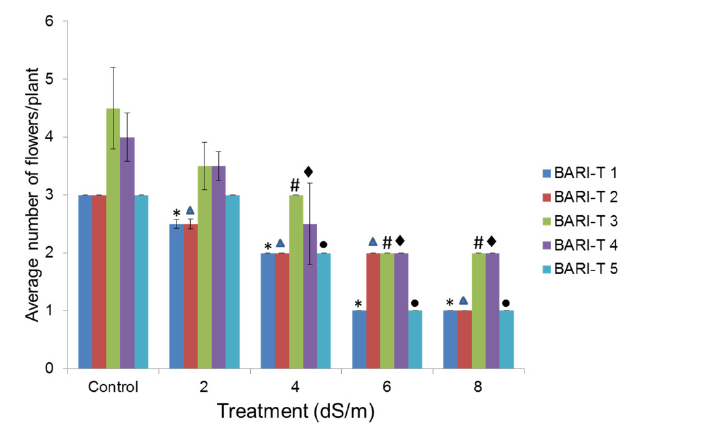
Fig. 5. Effects of NaCl-salinity on number of flowers in five BARI-T plants. Error bars indicate mean ± SD (n=3). Asterisk *, , #, ♦ , and • denote a significant difference between the saline-treated group and control group of BARI-T 1, BARI-T 2, BARI-T3, BARI-T 4 and BARI-T 5, respectively at p<0.05.